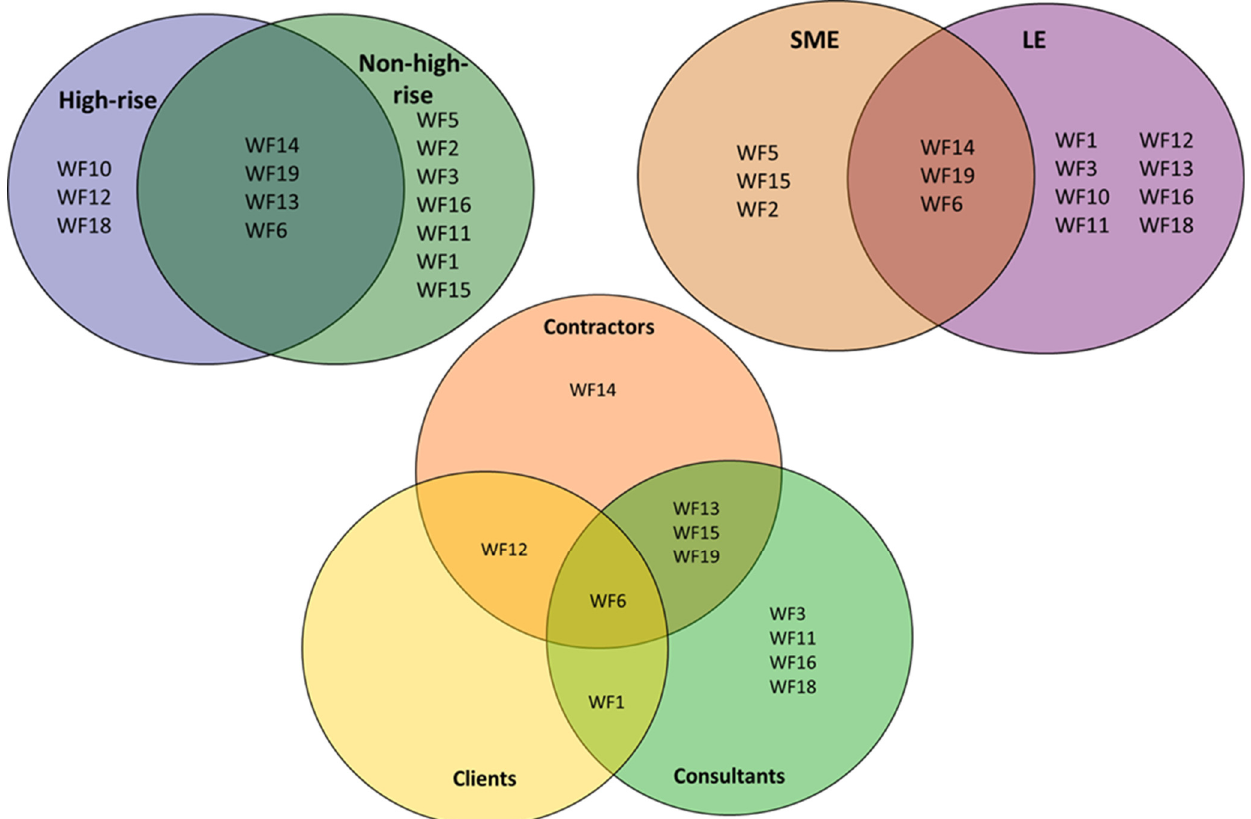
Figure 2. Results of overlap analysis.